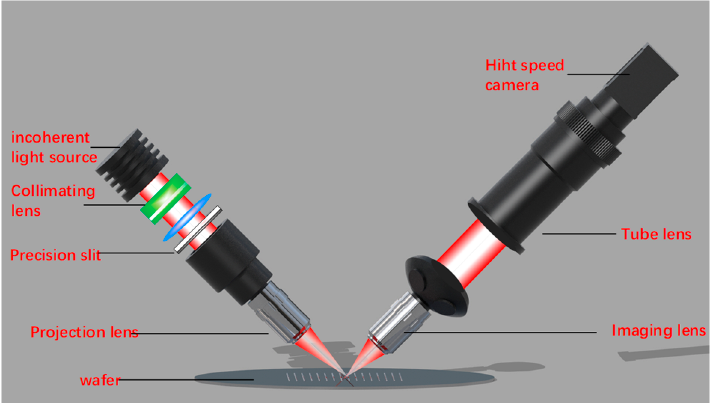
Figure 5. Schematic of the experimental setup for height measurement of micro bumps on a wafer.